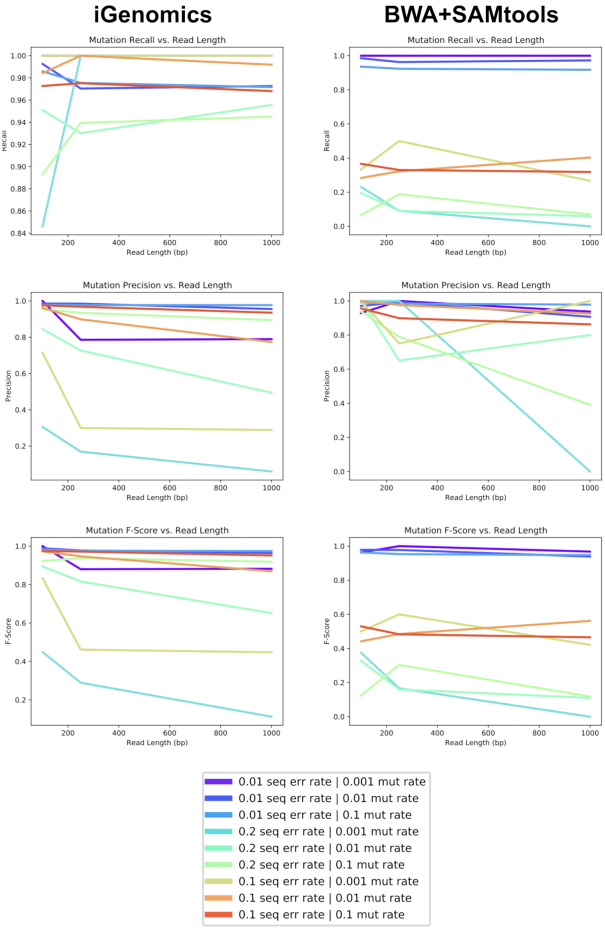
Mutation identification accuracy for simulated H1N1 flu datasets of varying mutation rates and error rates for iGenomics (left) and the BWA-MEM/SAMtools (right) pipeline. The top, middle, and bottom plots show recall, precision, and F-score, respectively.